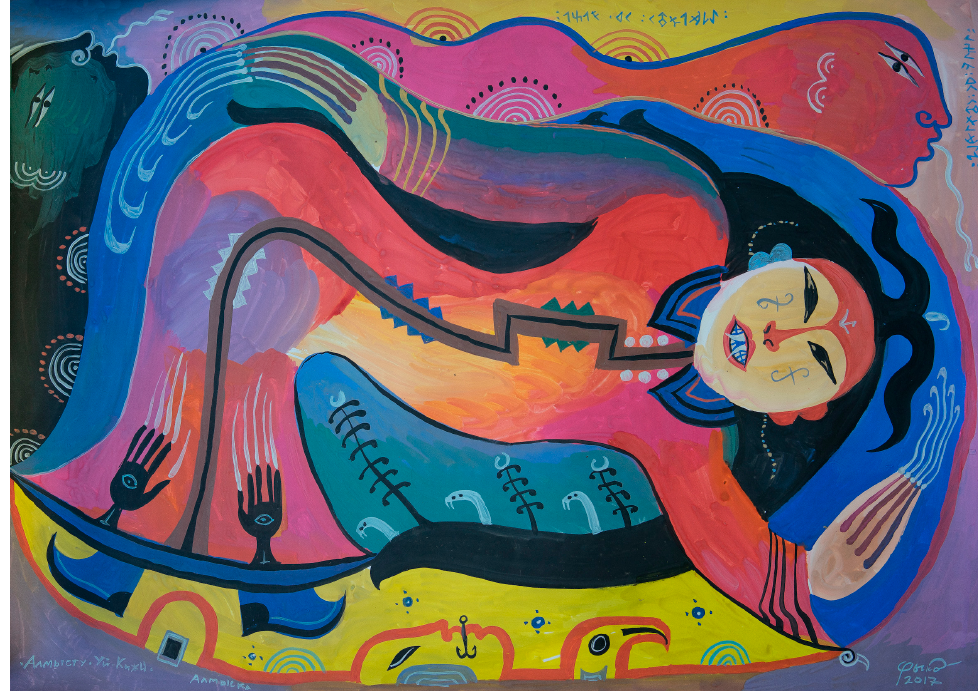
Figure 6. Sergei Dykov, Almys Woman , 2017, 43 × 61 cm, painting on paper. Photo: Andrzej Rozwadowski.